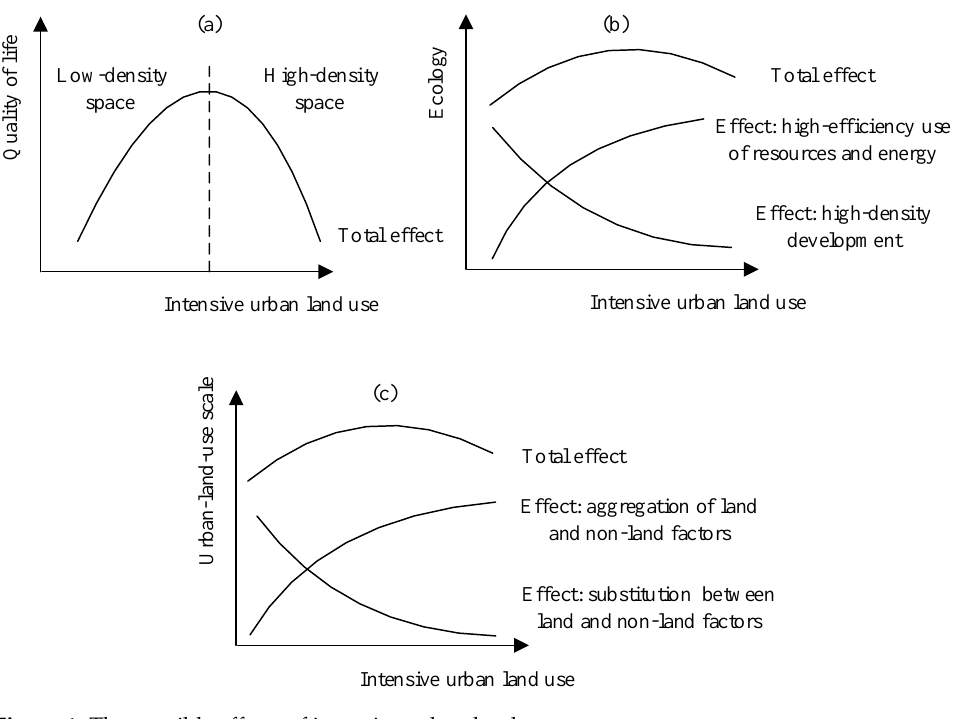
Figure 1. The possible effects of intensive urban land use.